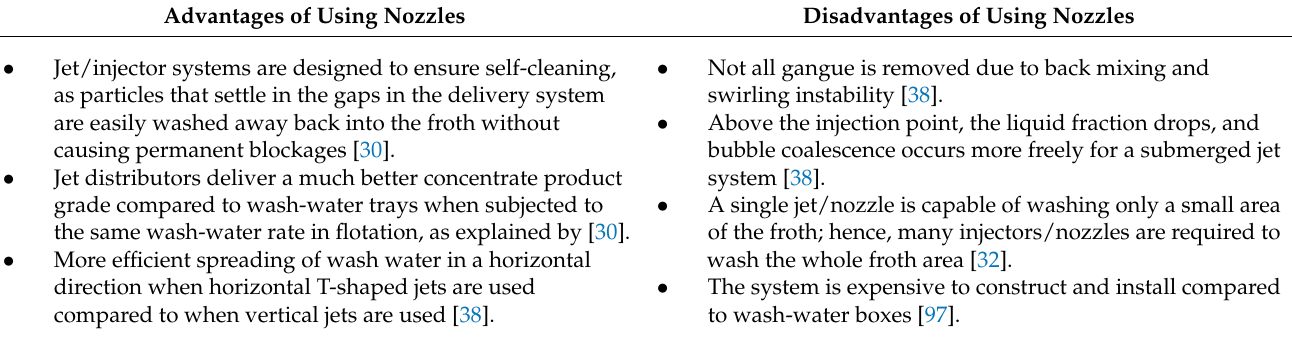
Table 2. Summary of the advantages and disadvantages of